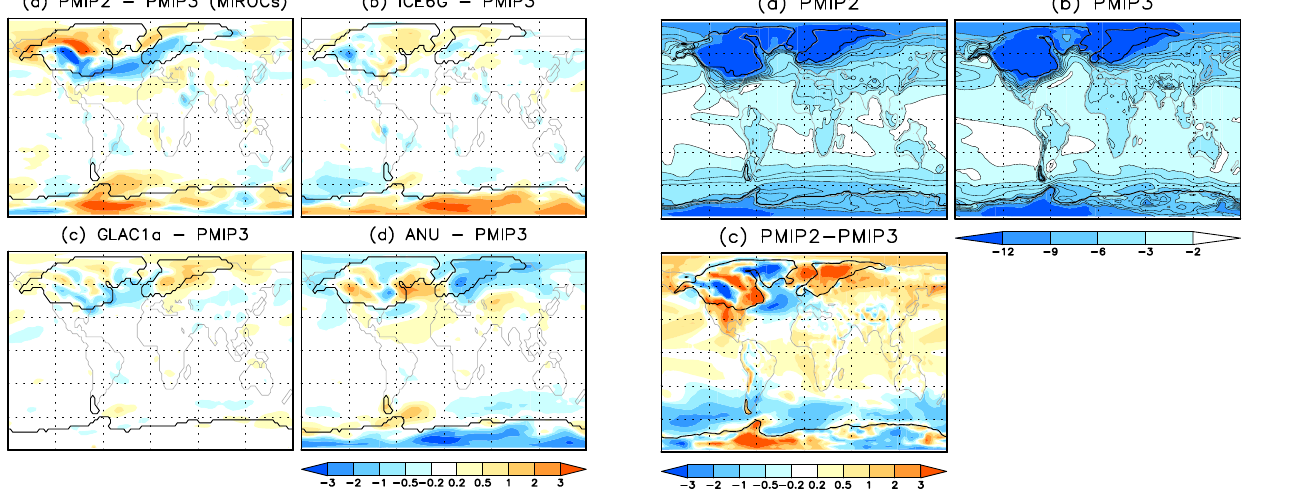
Figure 8. Change in mean annual temperature ( ◦ C) in the (a) PMIP2 and (b) CMIP5/PMIP3 coupled ocean–atmosphere sim- ulations. Each of these plots is an ensemble average of all the LGM simulations in PMIP2 and CMIP5/PMIP3 respectively. The differ- ence between the ensemble mean results for the two generations of experiments is shown in plot (c) . The land mask ( > 50% land) is shown in grey, and the ice margin ( > 50% ice) is shown in black in all plots. Contour lines in (a) and (b) are at 1 ◦ C intervals to − 9 ◦ C; temperature differences > − 9 ◦ C are not